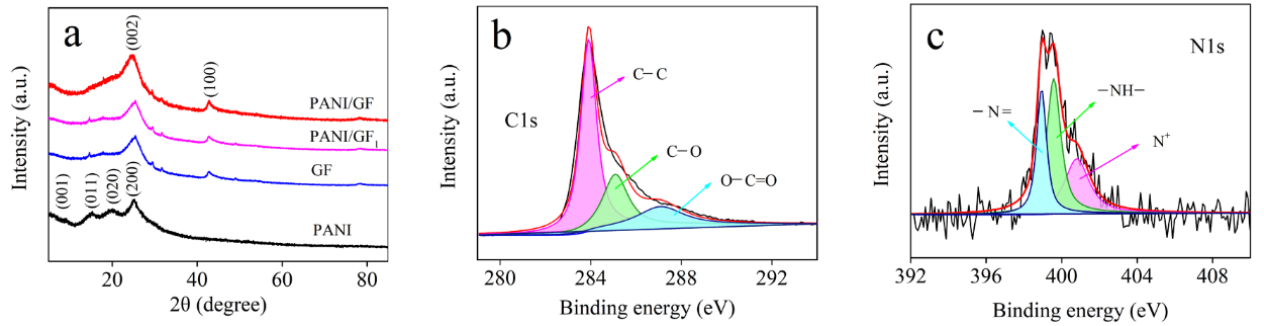
Figure 4. ( a ) XRD spectra of PANI, GF, PANI/GF 1 and PANI/GF; ( b ) XPS C1s and ( c ) N1s spectra of PANI/GF.